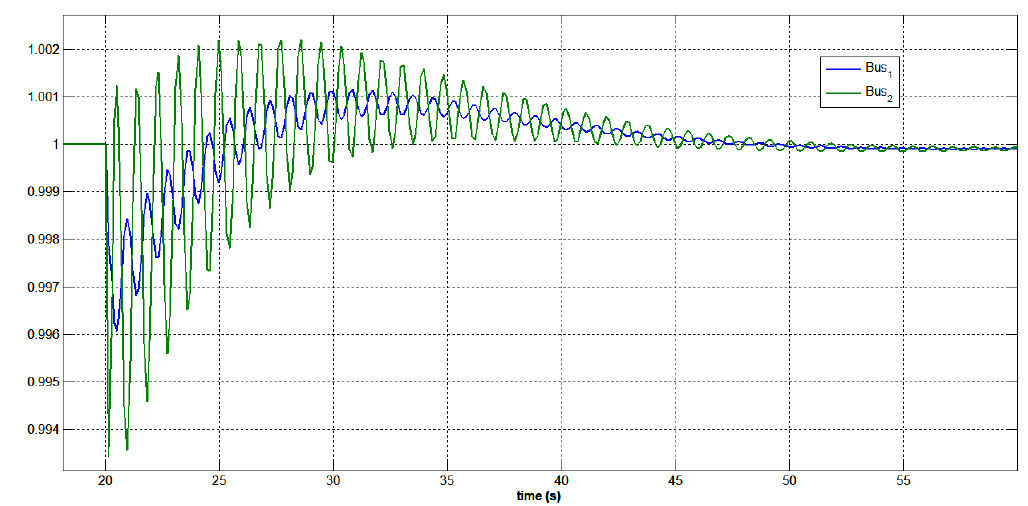
Figure 53. Rotor speed response of generators at the swing bus 1 and bus 3 under a three ‐ phase short circuit at bus 3 with STATCOM.